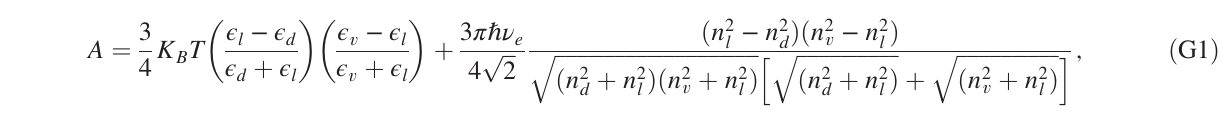
FIG. 11. Scaling of h thicknesses. Line of best fit in